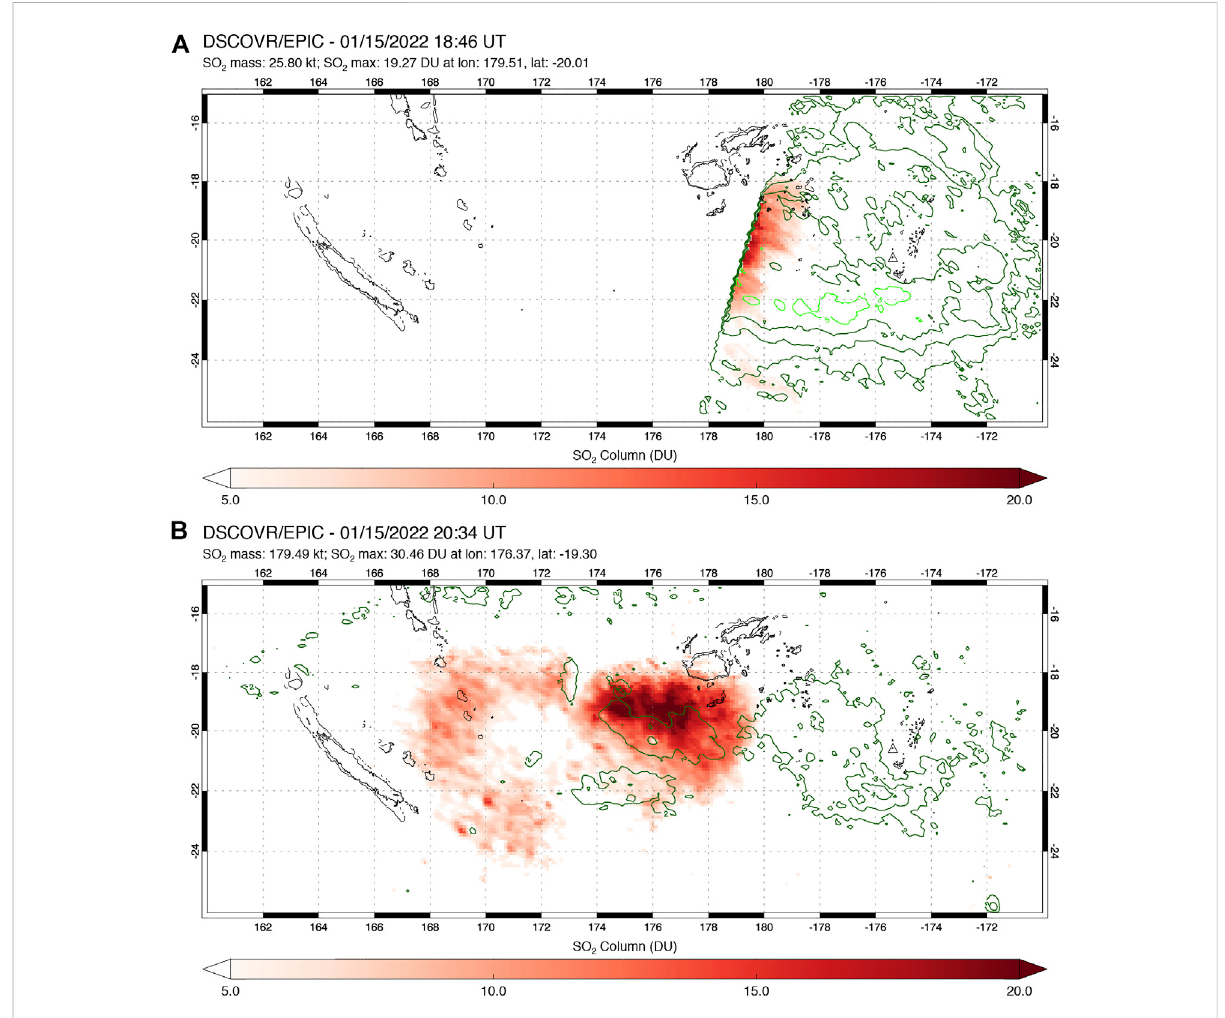
FIGURE 6 DSCOVR/EPIC observations of the 15 January 2022, HTHH eruption cloud. Green contours show the EPIC UV Aerosol Index (UVAI), where positive values indicate absorbing aerosols such as volcanic ash (but note the low UVAI values in this case). (A) Detection of the eastern edge of the plume at 18:46 UTC on January 15. The sharp boundary in the image is the terminator where the solar zenith angle becomes too high for UV measurements further west; (B) Full coverage of the volcanic SO 2 cloud at 20:34 UTC on January 15. Note the ~200 km westward drift of the SO 2 cloud in the 108 min between the two EPIC exposures. Scale: 1 ° in latitude/longitude corresponds to a distance of ~100